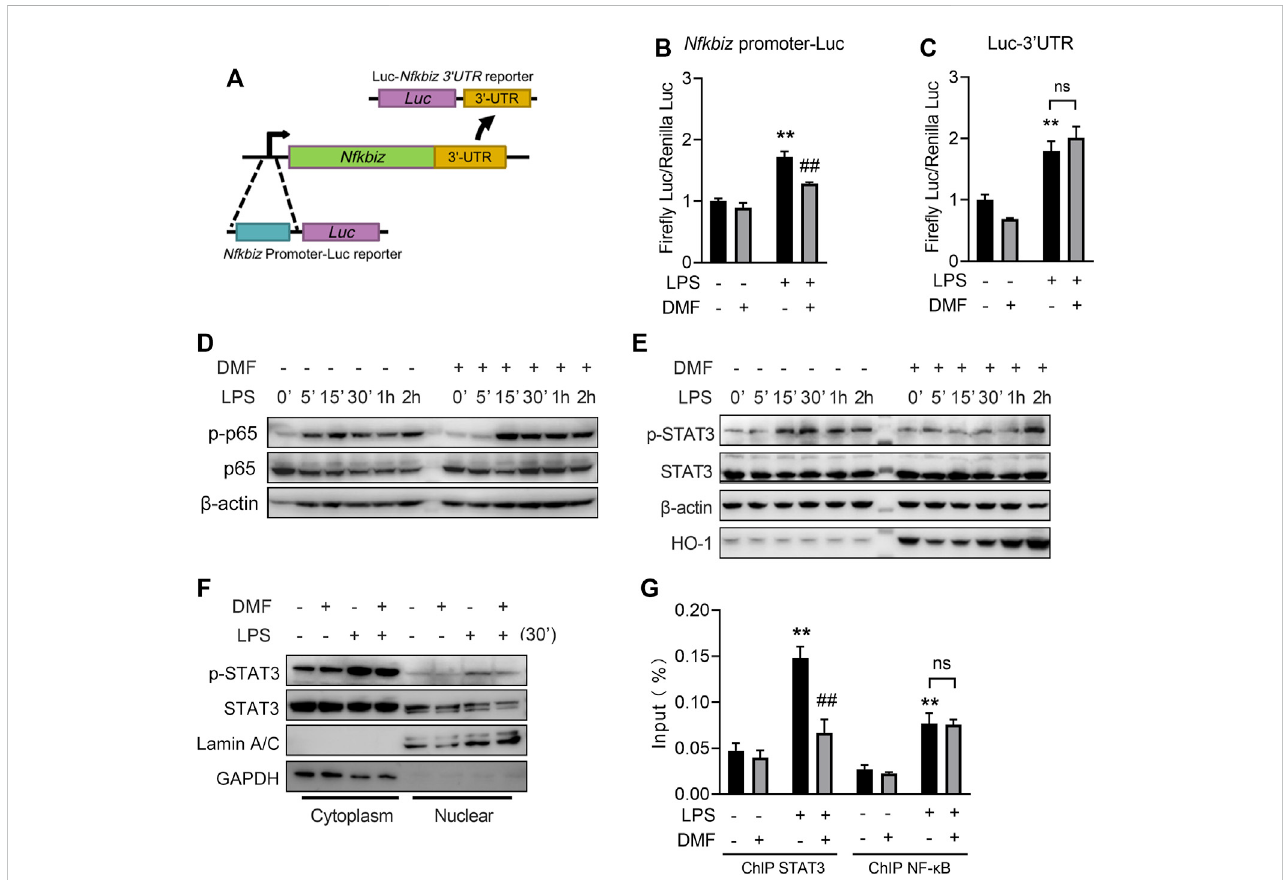
FIGURE 8 DMF inhibits I κ B ζ expression through the STAT3 pathway. (A) Construction of the Nfkbiz-promoter-Luc reporter and the Luc-Nfkbiz-3UTR reporter. (B) Cells transiently transfected with pGL4.13-Nfkbiz-promoter or pRL-TK were treated with 40 μ M DMF for 1 h and then stimulated with 1 μ g/mL LPS for 6 h, followed by the dual luciferase assay ( n = 3). (C) Cells transiently transfected with pGL4.13-Nfkbiz-3UTR or pRL-TK were treated with 40 μ M DMF for 1 h and then stimulated with 1 μ g/mL LPS for 6 h, followed by the dual luciferase assay ( n = 3). (D,E) Cells were treated with 40 μ M DMF for 1 h and then stimulated with 1 μ g/mL LPS in the absence of DMF for the indicated time. Western blot analysis of the indicated proteins. (F) Cells were treated with 40 μ M DMF for 1 h and then stimulated with 1 μ g/mL LPS in the absence of DMF for 30 min. The cytoplasmic and nuclear fractions were isolated for western blot analysis. (G) Cellsweretreatedwith40 μ MDMFfor1 handthenstimulatedwith1 μ g/mLLPSfor6 h.ChIP ‒ qPCRanalyseswereperformedusingSTAT3 (G) or NF- κ Bantibody (H) ( n = 3). ** p < 0.01 vs. theuntreated group by one-way ANOVA. ## p < 0.01 vs. the LPS group by one-wayANOVA; ns, not signi fi cant vs. the indicated group by t